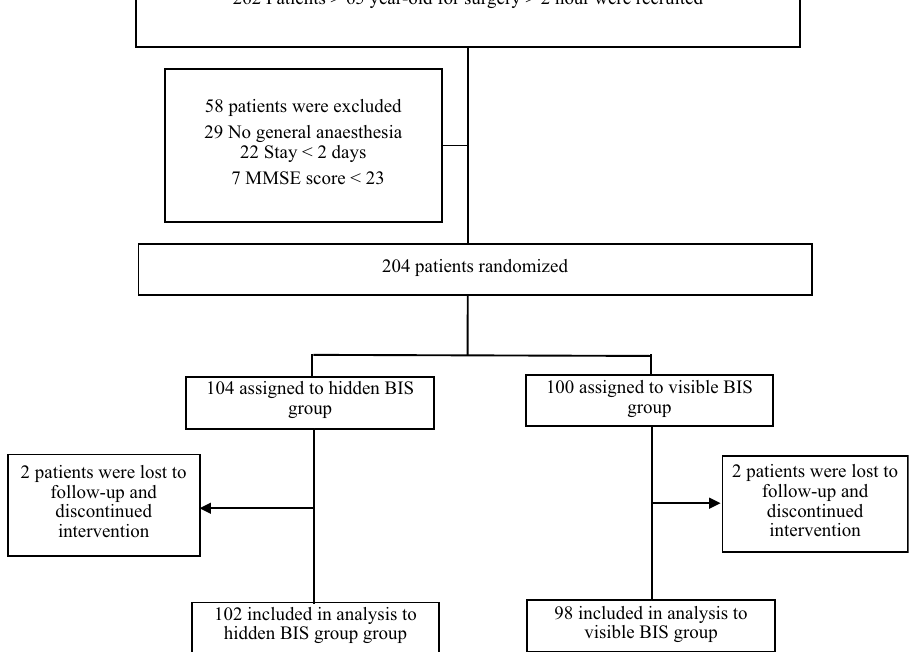
Figure 1. STROBE patient flow diagram. Screening, randomization, and the follow-up. BIS indicates bispectral index; MMSE mini-mental state